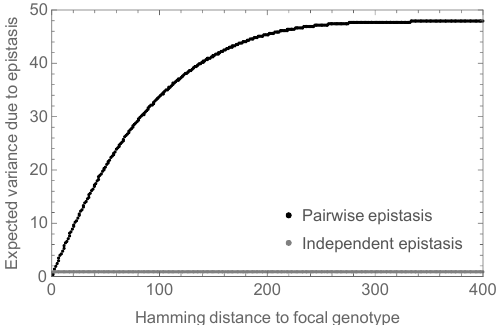
Figure 3. Expected epistatic variance as a function of distance from the focal sequence for amino acid sequences of length l = 400. Results for the pairwise epistasis model shown in black, results for the independent epistasis model shown in gray. All variances are normalized relative to the expected variance at Hamming distance d = 2 which is set to 1. Notice that the epistatic variance at large distances is much larger than the epistatic variance at distance d = 2 for the pairwise epistasis model but not for the independent epistasis